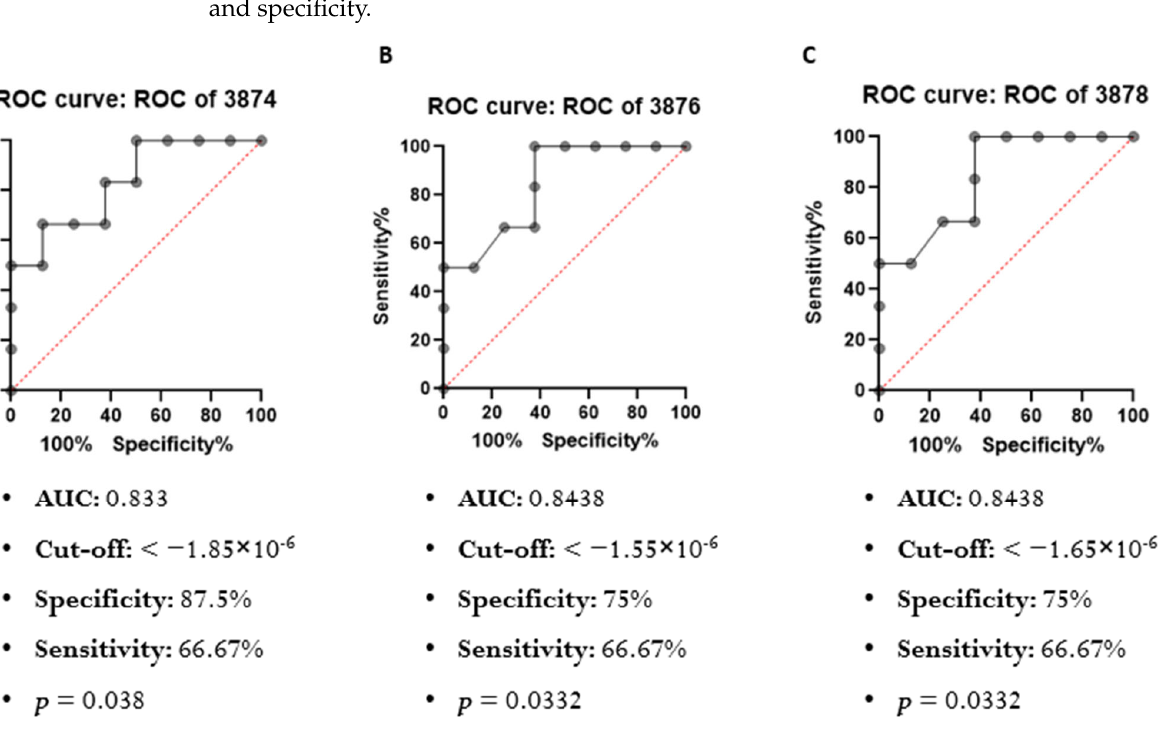
Figure 3. ROC Curve for HER2+ vs. BBD. ( A ) 3874 cm − 1 ; ( B ) 3876 cm − 1 ; ( C ) 3878 cm − 1 .